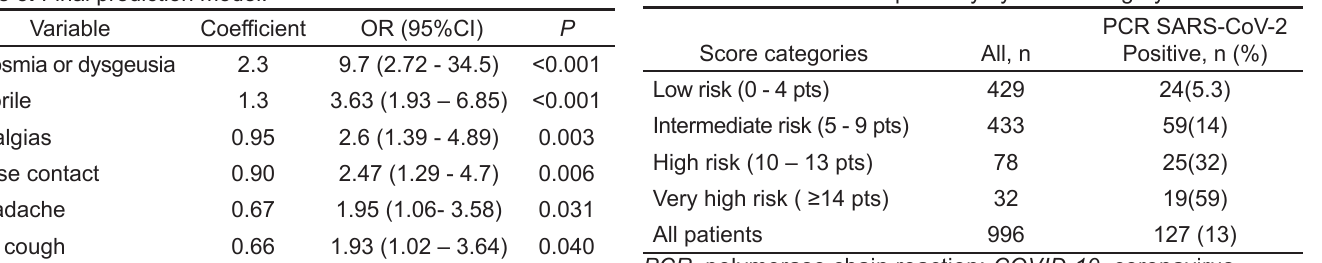
PCR, polymerase chain reaction; COVID-19, coronavirus disease